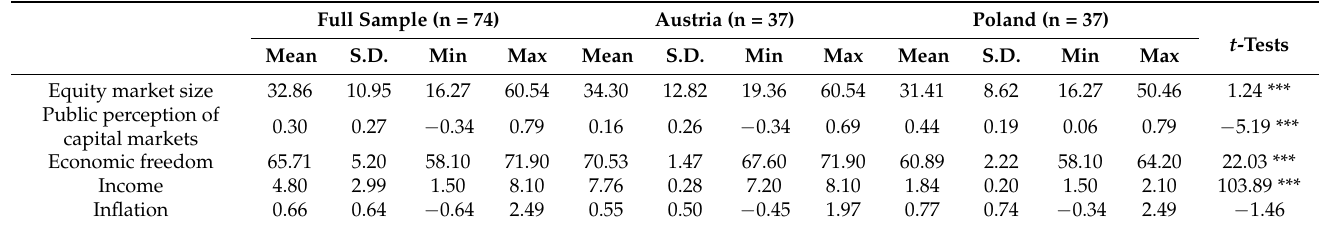
Table 2. Descriptive